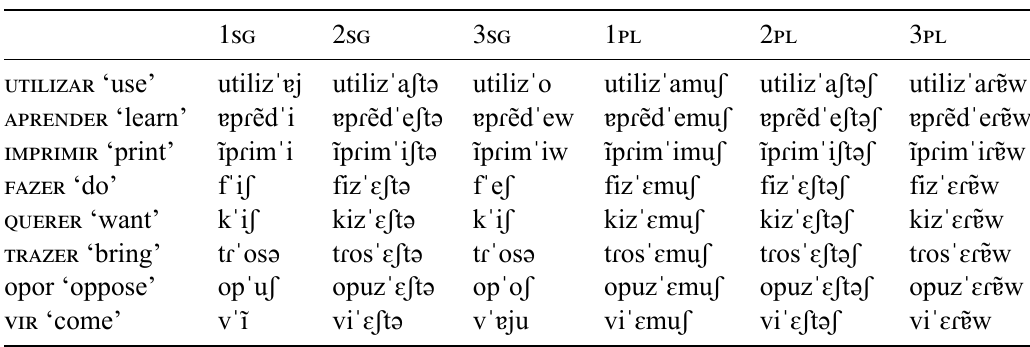
Table 15: Representative examples of the perfective preterite paradigm in /z/ (the /z/ is palatalised and devoiced word­finally, a regular phonological process), as well as QUERER ‘want’ and its derivatives, which are the only verbs with a stem ending in /kˈɛɾ/. In both cases, the specific phonotactic characteristics of the subclass avoid any ambiguity: no verb ends in /ʃ/ or /kˈɛɾ/ in the 3SG if it does not fall under one of these cases; the same applies to verbs ending in /zәʃ/ or /kˈɛɾәʃ/ in the 2SG .